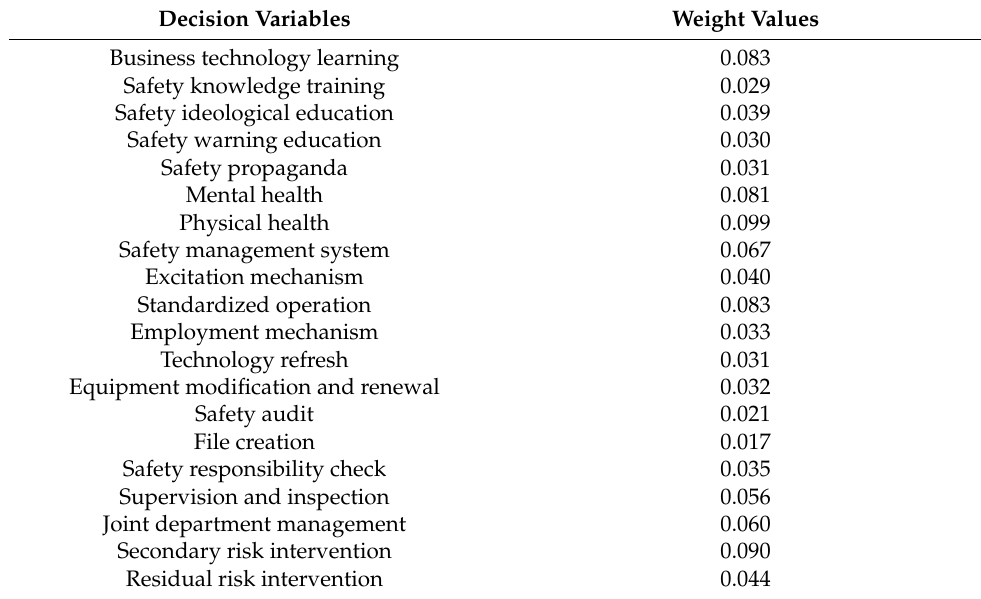
Table 6. Coping strategy weight values of grid G H